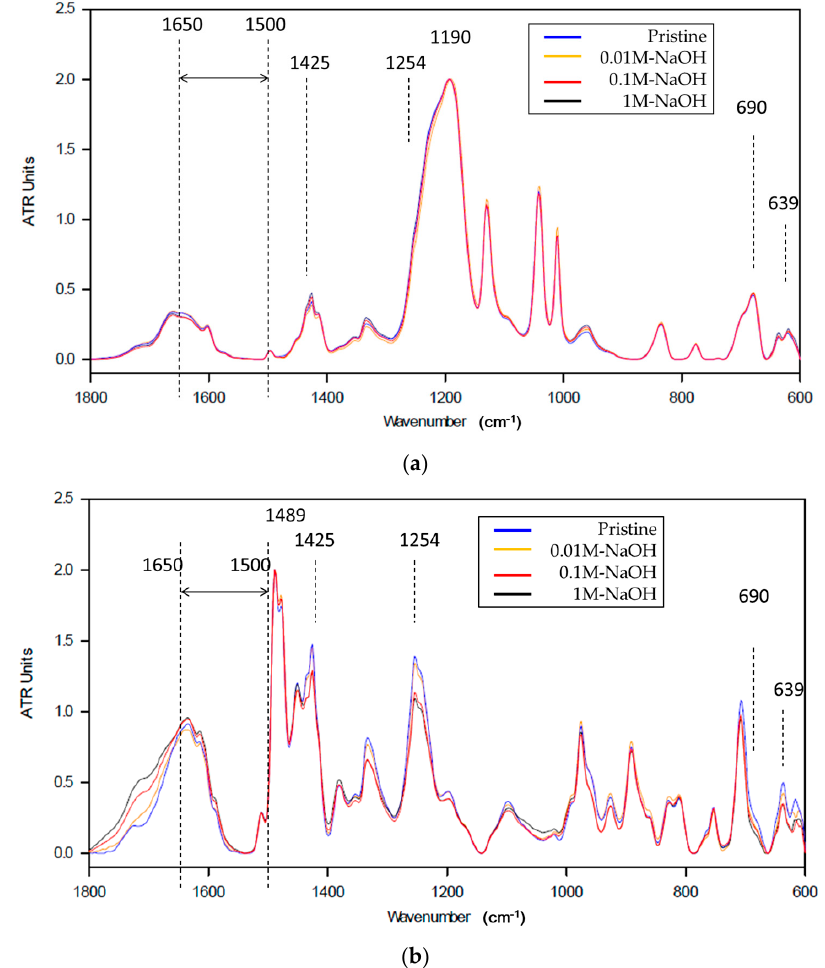
Figure 6. ATR-FTIR spectrum for ( a ) CMX and ( b ) AMX membranes before and after soaking in solutions with different NaOH concentrations.